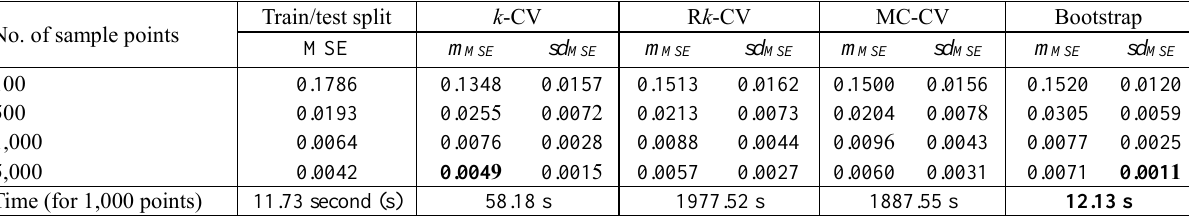
Figure 2. Classification by a neural network: (a) an artificial non-linear 2D data (500 points) set having five different spirals, (b) classification into five different regions (colours), (c) confusion matrix for the classification, (d) histograms of density versus MSE, MSE of 1,000 samples of 100 points follows a Normal distribution (magenta curve).